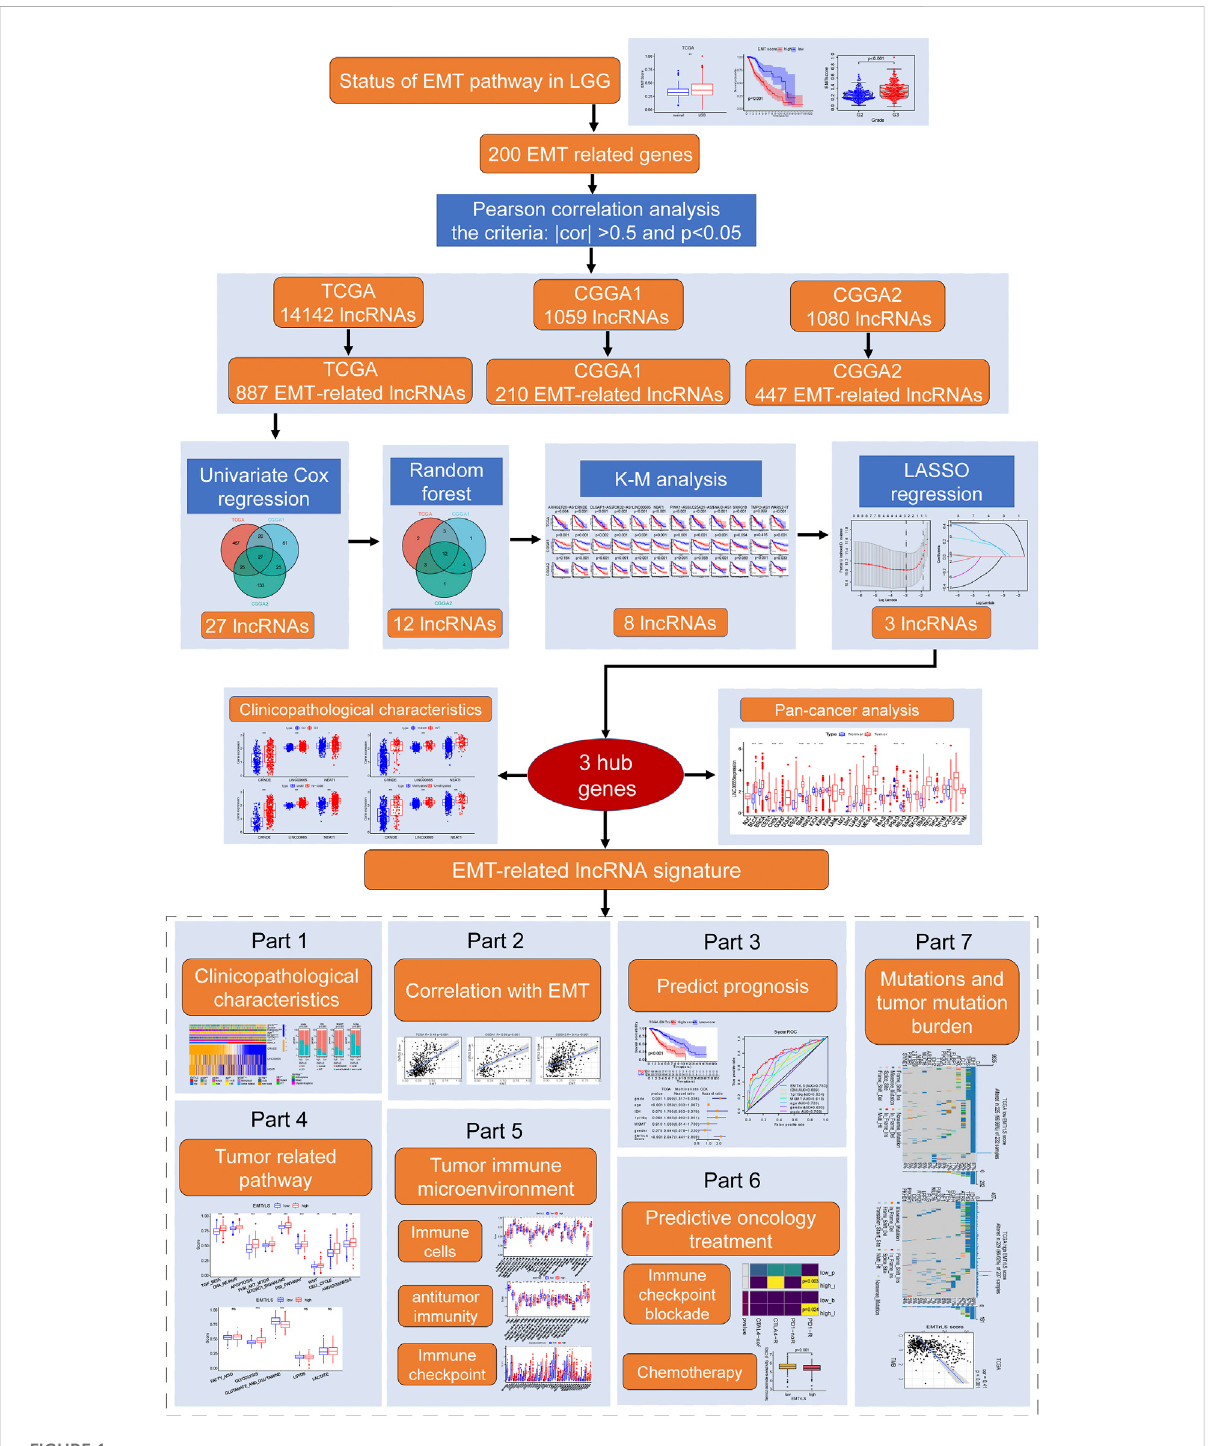
FIGURE 1 Flow chart of this